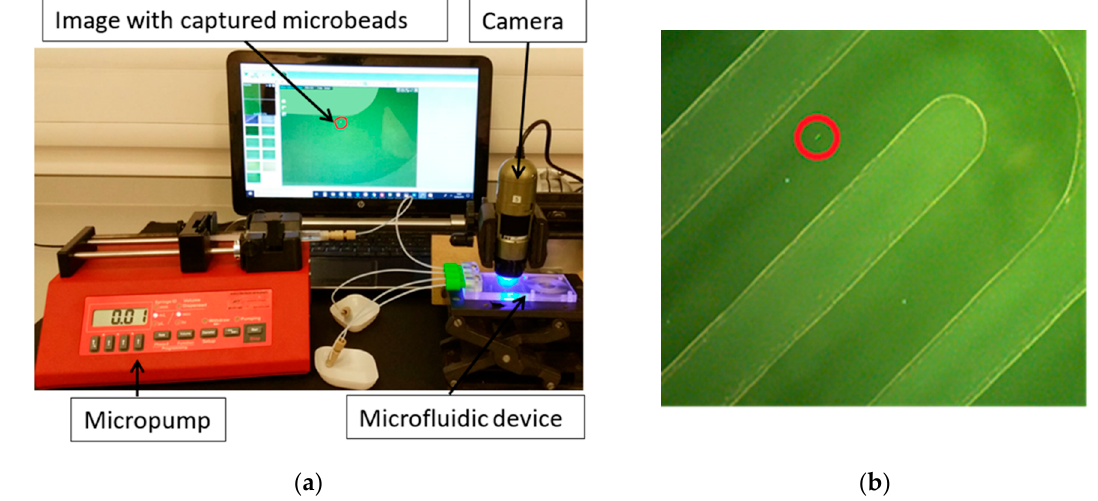
Figure 1. ( a ) The system setup includes a syringe pump and a USB camera with 500–900 times zoom; ( b ) image detection of the microbeads of 1–5 µm within the microfluidic